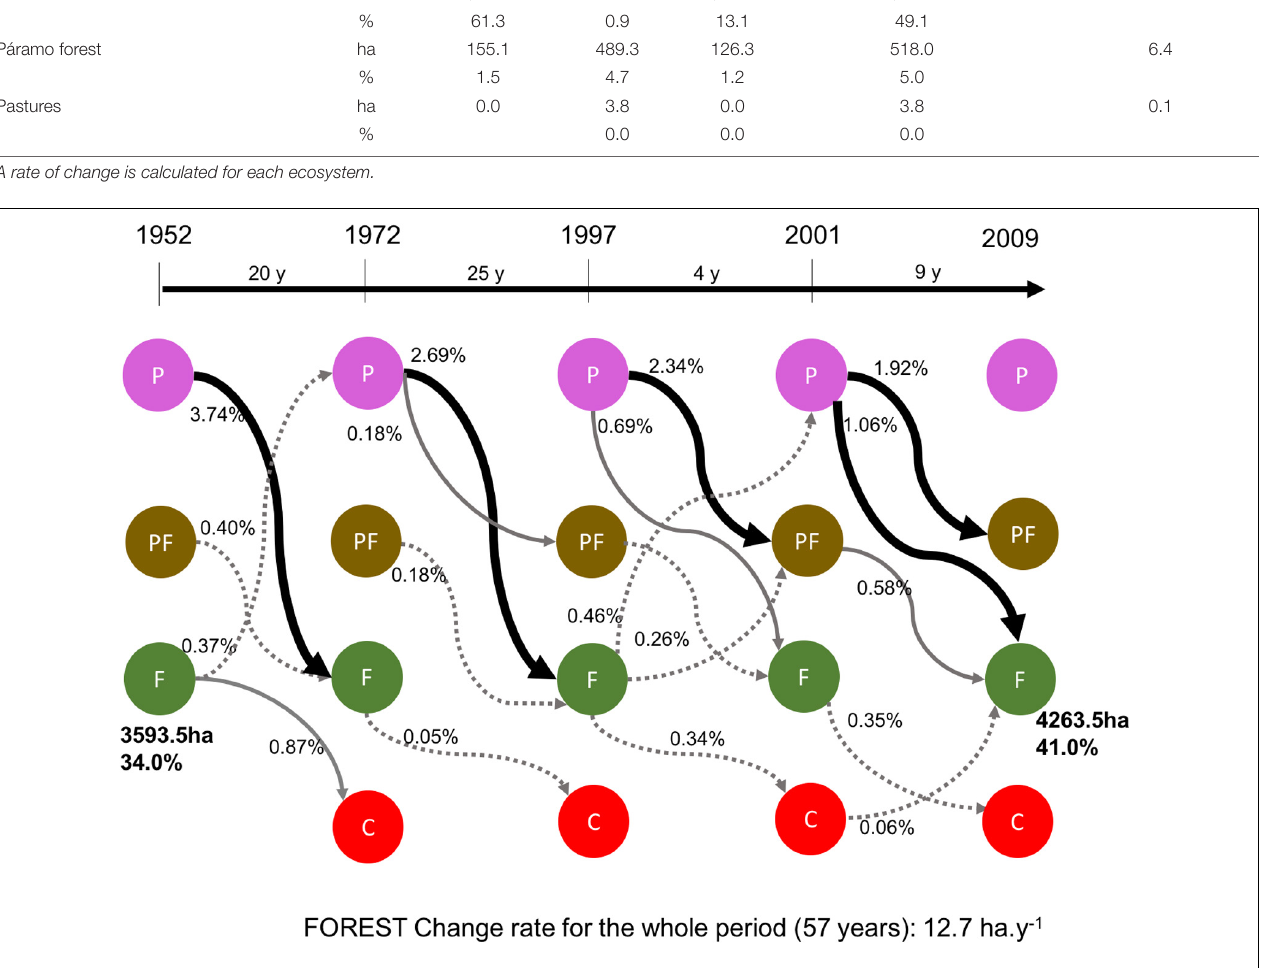
FIGURE 3 | Model of main ecosystems transition of the Capaz study area (P: Páramo, F: Forest, PF: Páramo forest, and C: Crops) and trajectories of change (arrows) of the different period of study for ecosystem and replacement systems (thick continuous black arrow % change > 1, continuous thin gray arrow % change < 1 and > 0.5, thin dotted gray arrow % change < 0.5 and > 0.05, % < 0.05 is not indicated). Accumulated % of change is indicated for each arrow and the total and % area for forest ecosystem at the beginning and the end of the whole